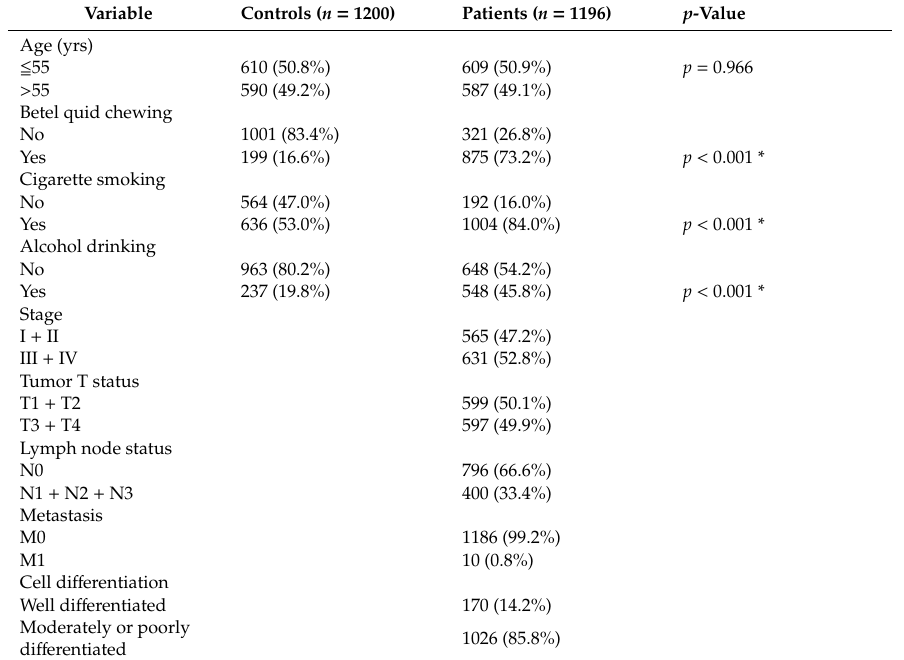
Table 1. The distributions of demographical characteristics in 1200 controls and 1196 male patients with oral cancer.